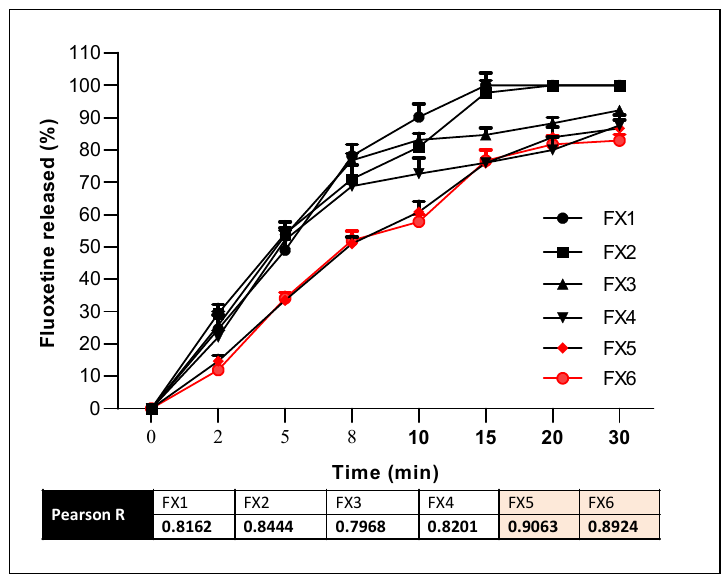
Figure 5. Dissolution profiles and correlation coefficients—Pearson r. The results obtained are comparable with the ones published by Lu Zhang et al. in released after 20 min [23].